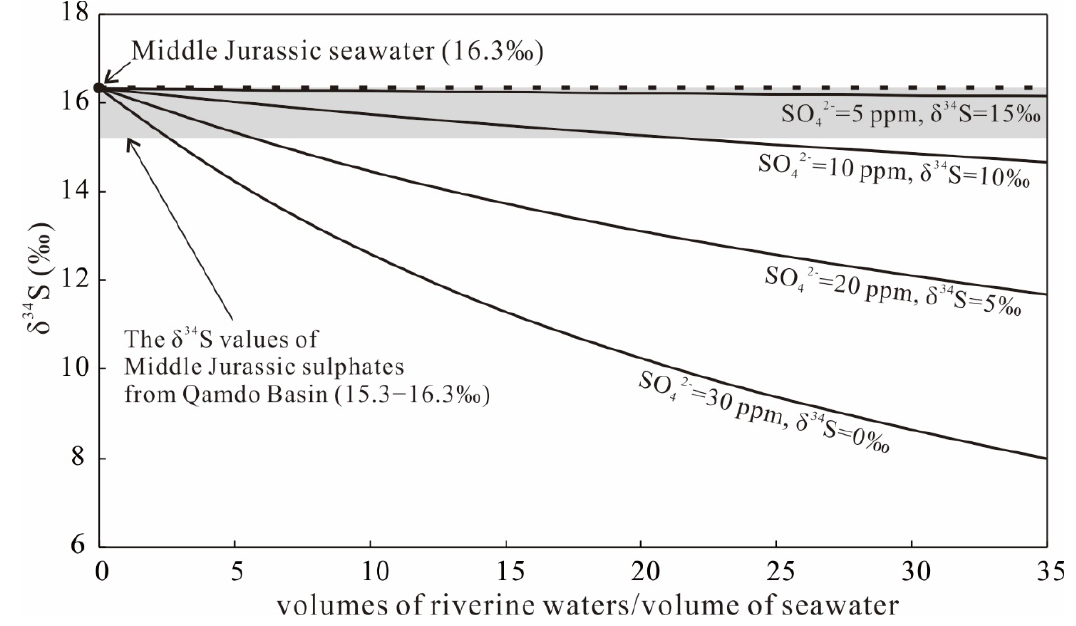
Figure 7. Mixing curves for various SO 42 − concentrations and δ 34 S values of riverine waters with seawater ( δ 34 S = 16.3‰, SO 42 − concentration = 1005 ppm).